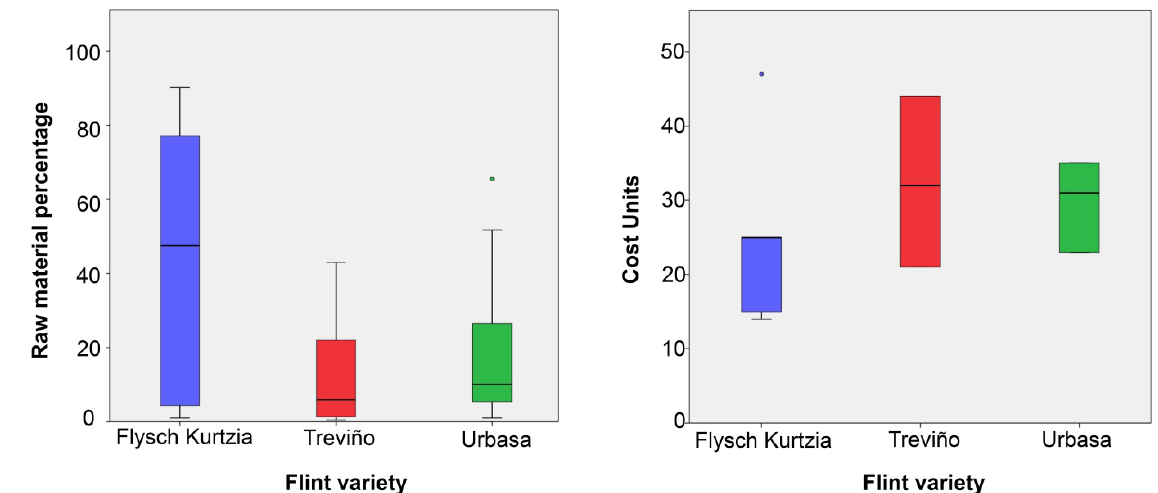
Figure 9. Double boxplot. The first plot shows the different varieties of flint on the horizontal axis and the Cost Units needed to reach each archaeological site with presence of that variety on the vertical axis. The second plot displays the percentage of flint from each outcrop identified in the all the archaeological sites under